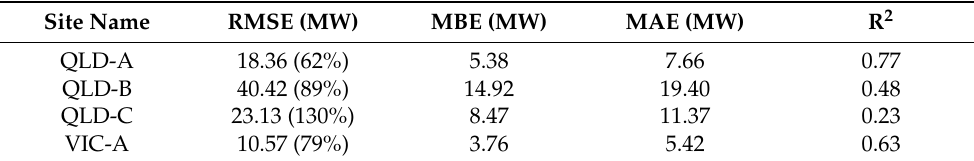
Table 8. Error metrics for predicted mean power ensemble for the live period.